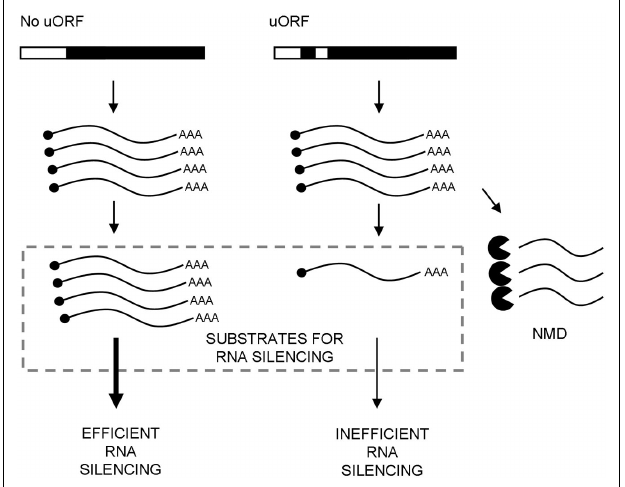
FIGURE 2 | Model for the relationship between nonsense-mediated decay (NMD) and induction of RNA silencing in plants. The gene on the left hand side expresses a single open reading frame (filled), while the gene on the right hand side has an additional small upstream ORF (uORF; filled) in the 5 (cid:2) UTR (open) that causes premature termination by the scanning ribosome.Transcripts containing uORFs may therefore be partially subject to NMD and reduce the pool of RNA molecules that would otherwise contribute the threshold-dependent induction of RNA